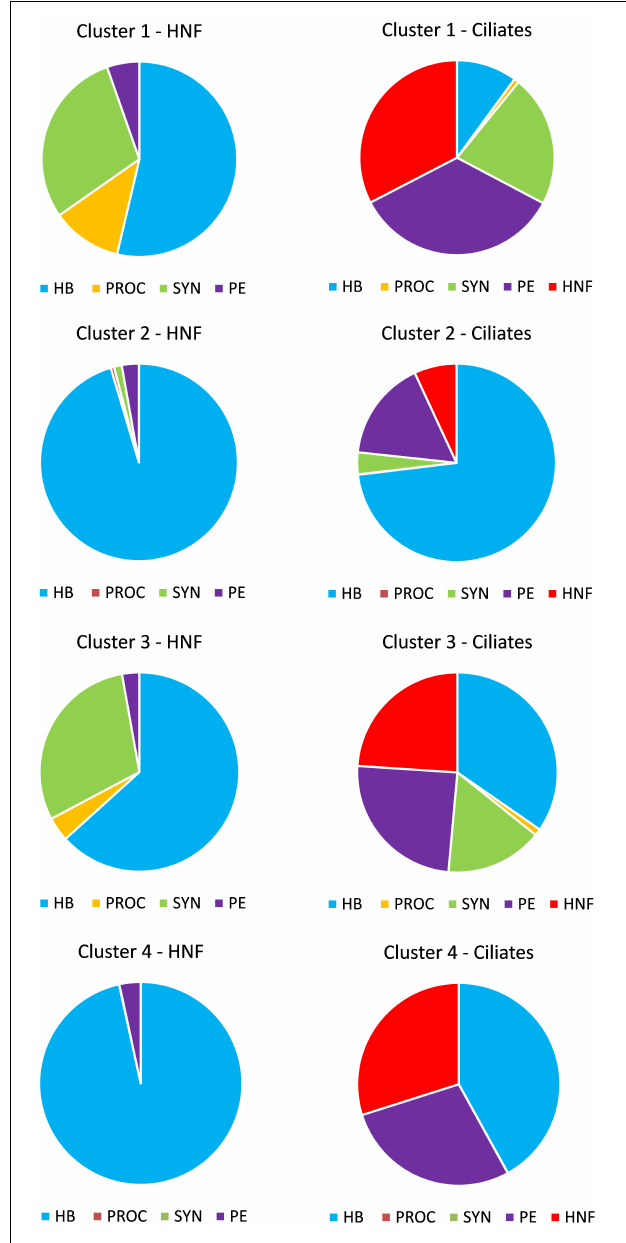
(65%) and by ciliates in the other three clusters (from 57 to 78%) ( Supplementary Figure 5 ).